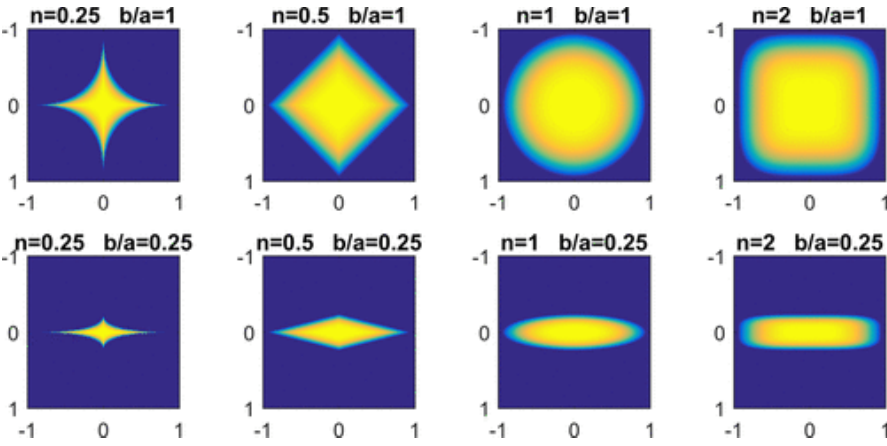
Figure 6. Colour map of ψ c as described in Equations (12) and (18) for several values of n and b / a . The particles are assumed to have no rotation φ = 0 and larger semiaxis a = 1. Reprinted with permission from Ref. [160] Copyright 2019 American Chemical